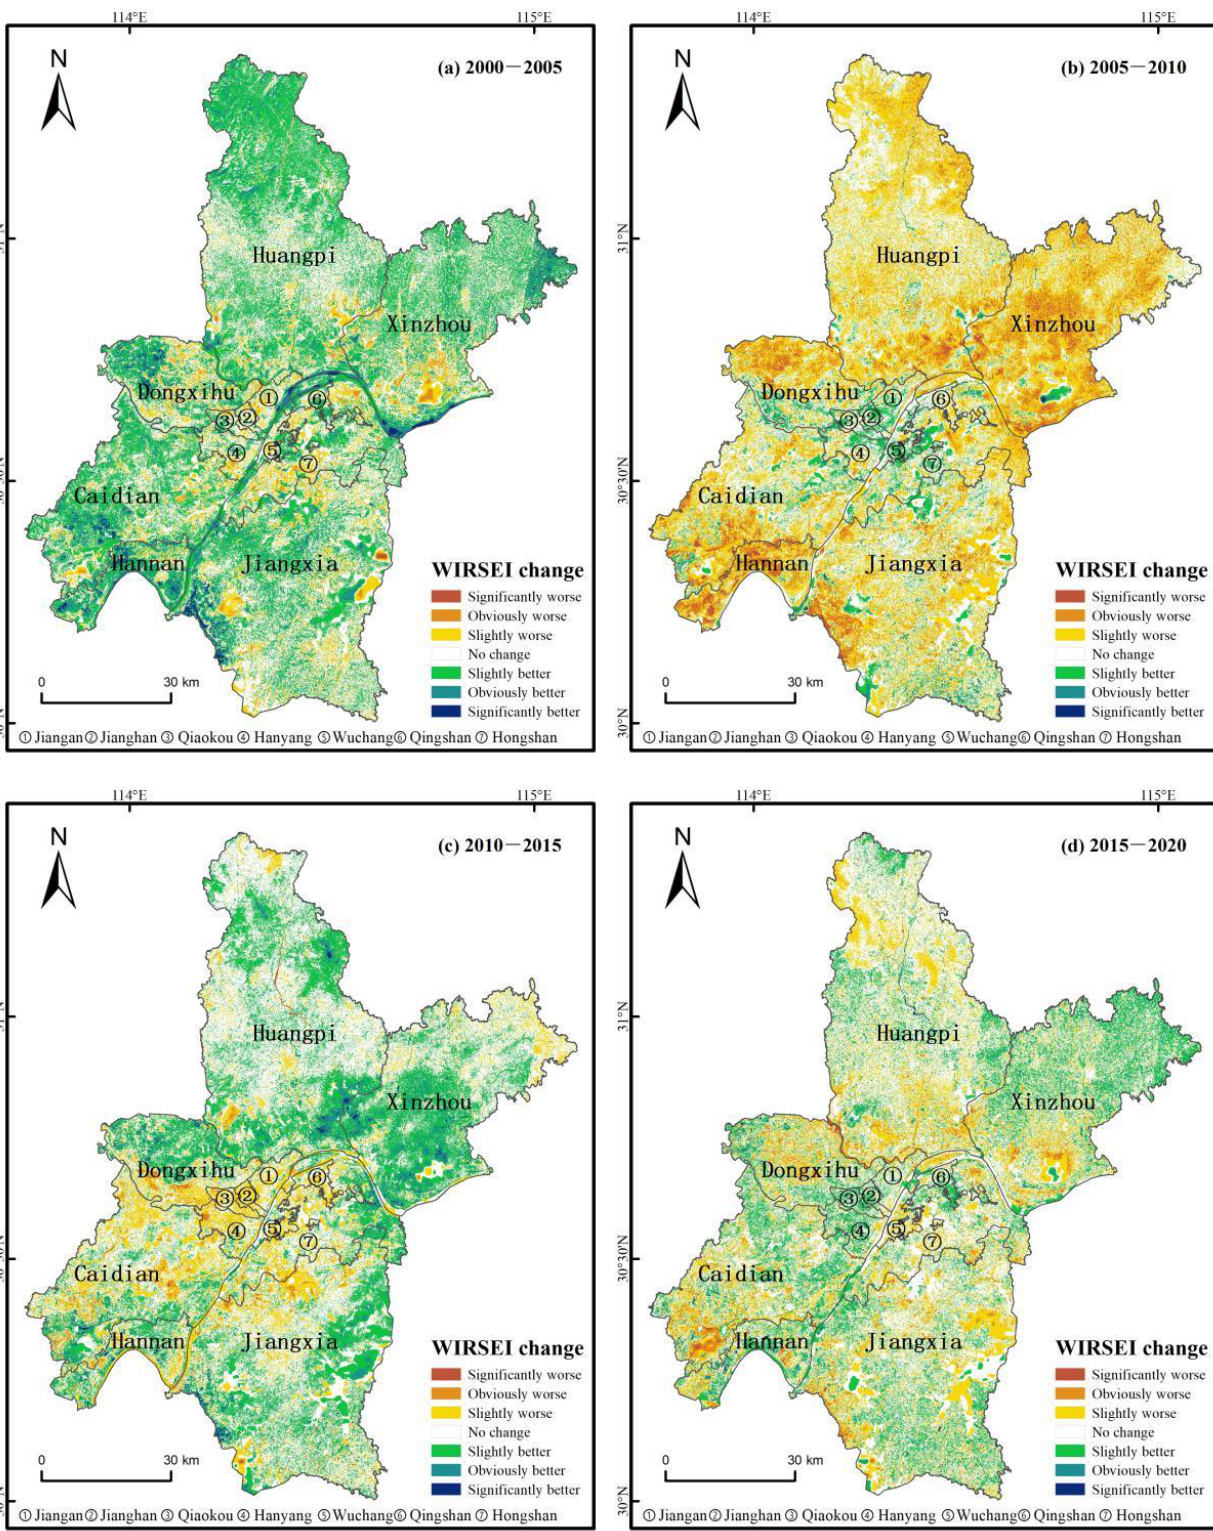
Figure 8. Spatial transfer distributions of the ecological levels of the WIRSEI in Wuhan from 2000 to 2020.